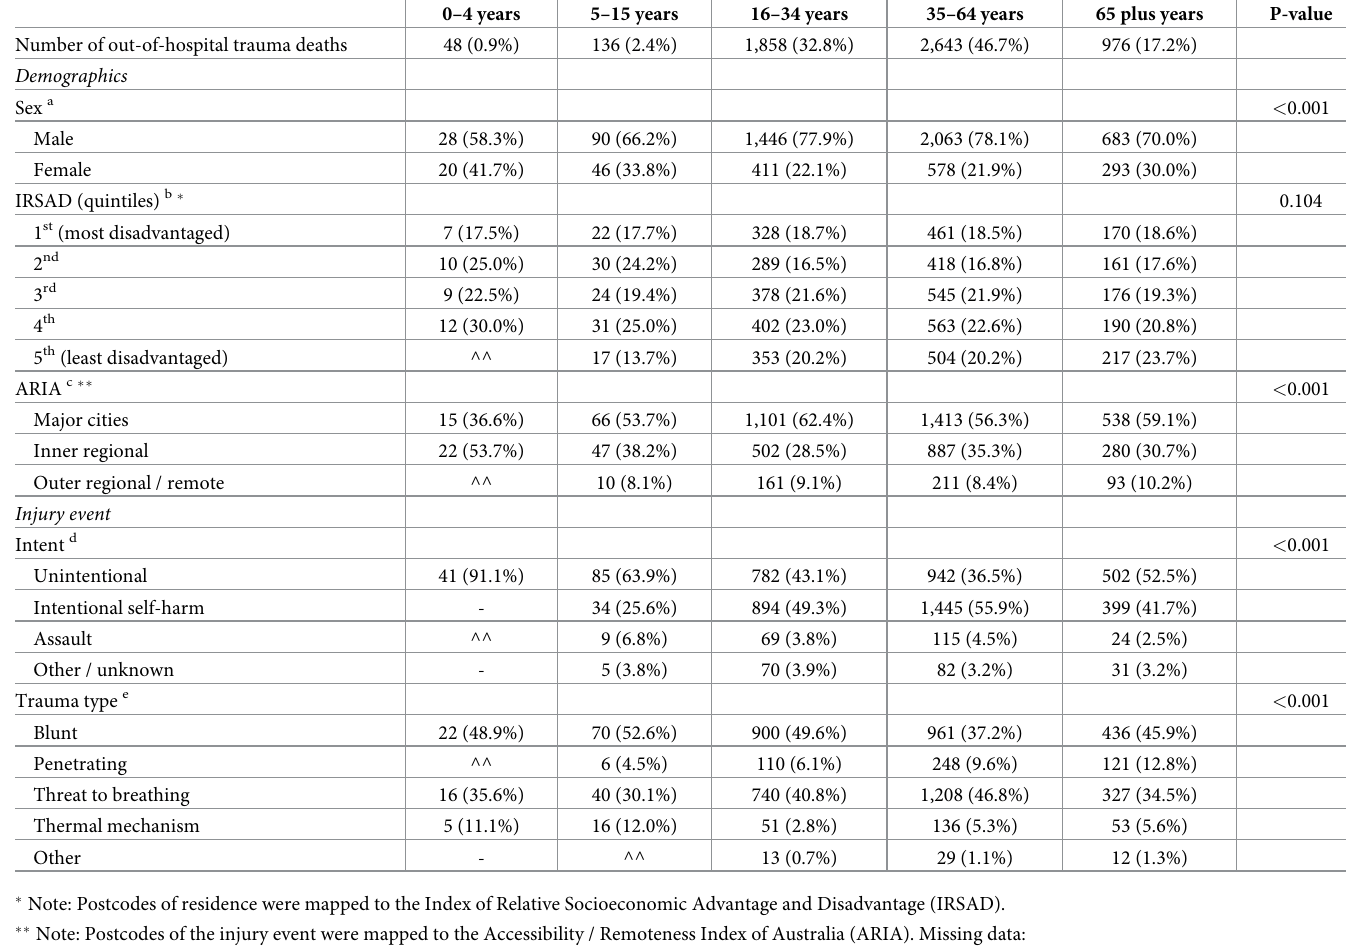
Table 3. Demographic and injury event profile of cases by age group for out-of-hospital trauma